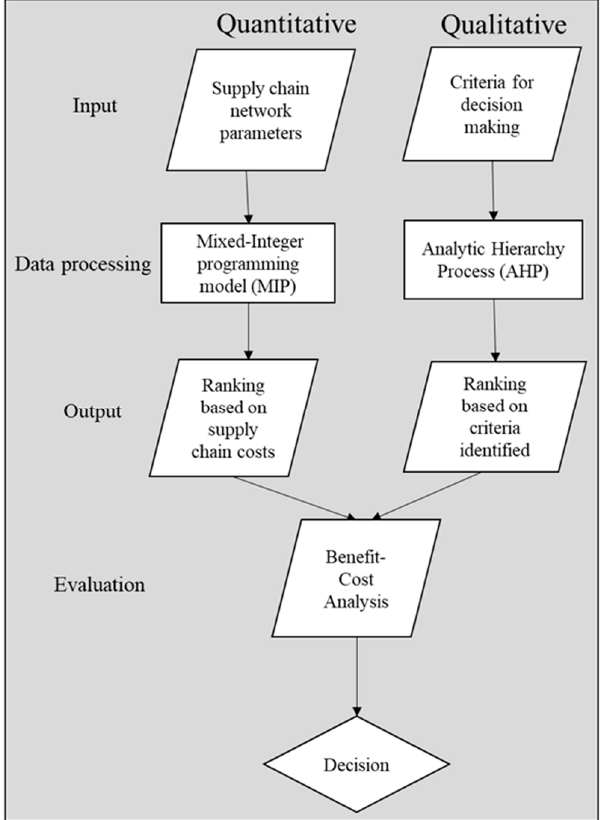
Figure 1. Proposed framework for terminal selection decision ‐ making.